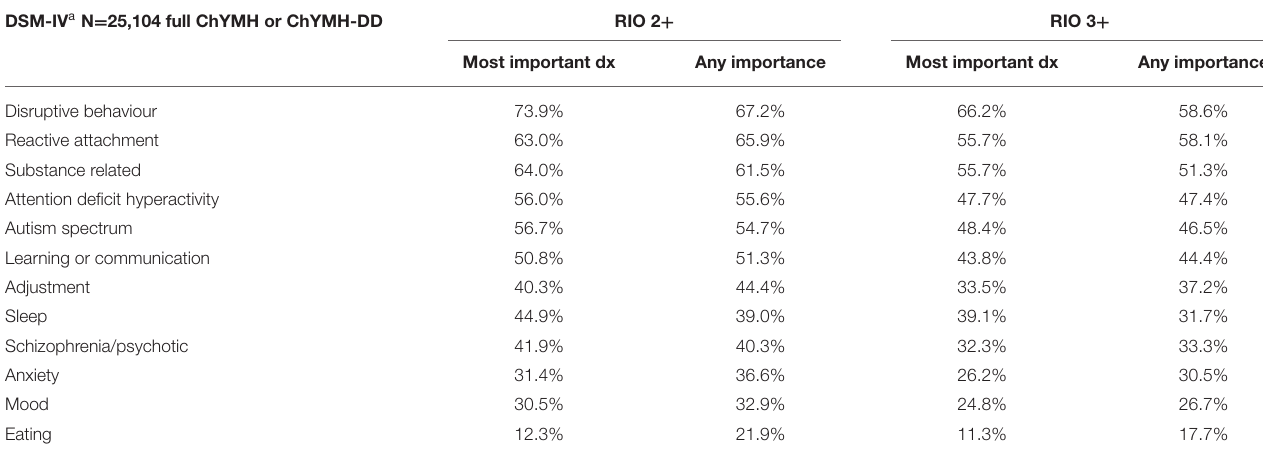
TABLE 6 | Risk of Injury to Others (RIO) algorithm by DSM diagnosis.